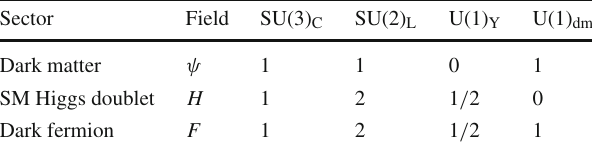
Table 6 Particle content and quantum numbers of the DM fermion scenario with the SM Higgs and a dark fermion